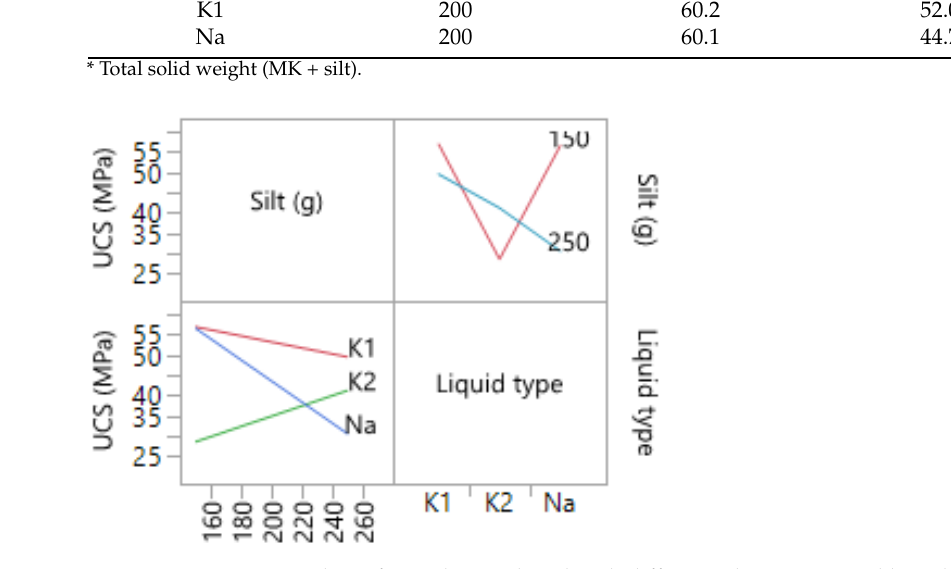
Figure 13. Interaction plots of samples produced with different silt amounts and liquid types.